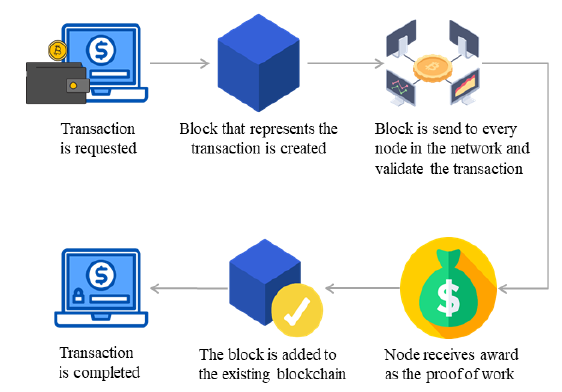
Figure 1: Working of Blockchain [6]